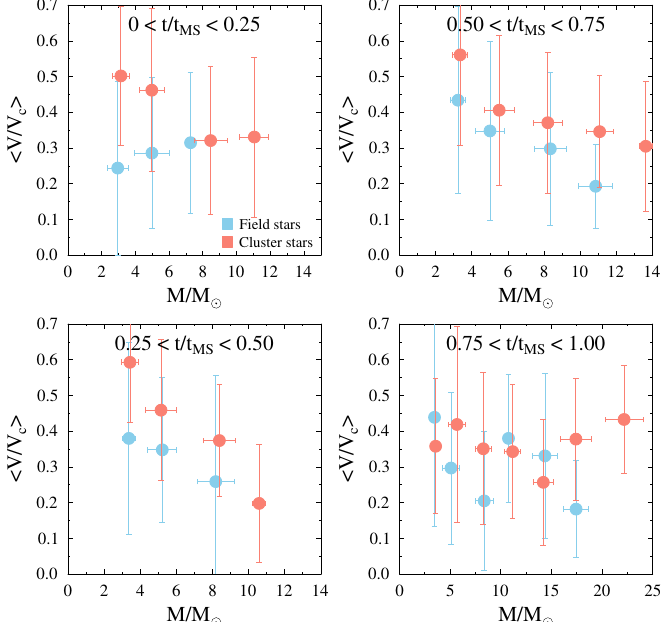
Figure 29. Average ratios of true velocities V / V c of field and cluster B-type stars against the stellar mass M / M (cid:12) per fractional age t / t MS